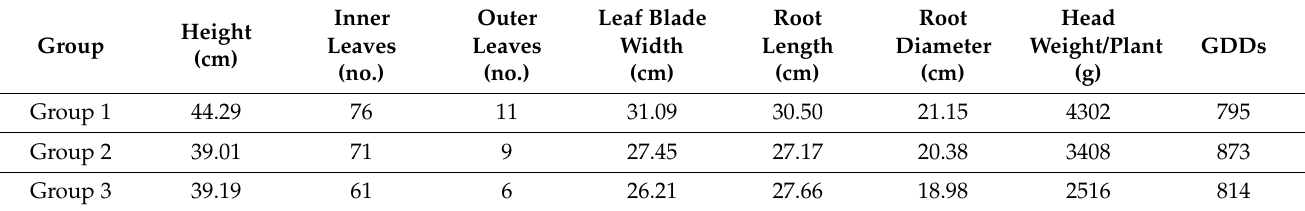
Table 4. Morphological characteristics of height, number of inner leaves and outer leaves, leaf blade width, root length, root diameter, and head weight of the three Chinese cabbage cluster groups created in this